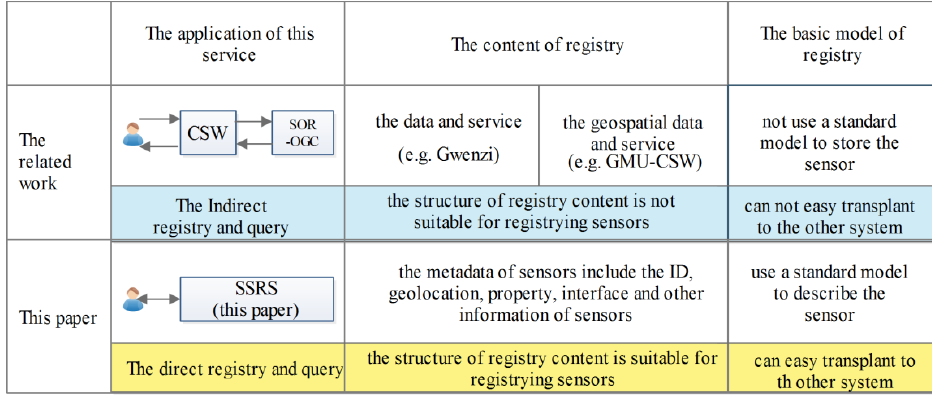
Figure 10. Comparison with other semantic registry services.